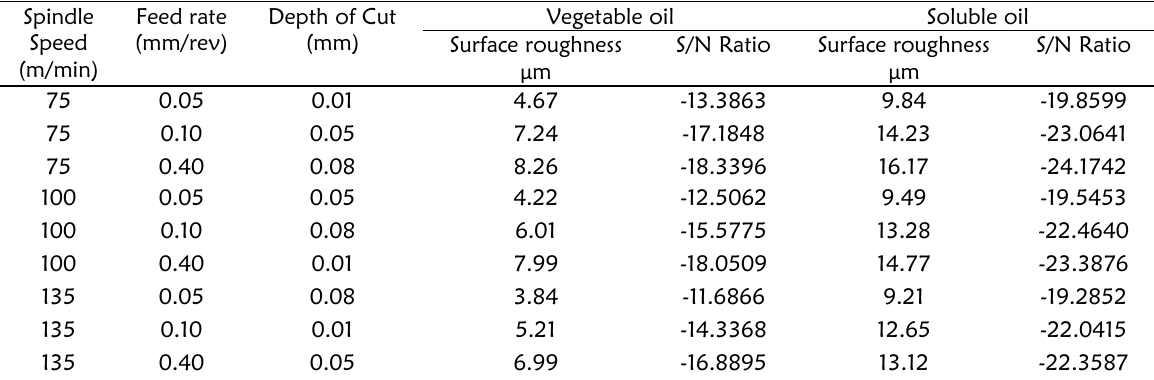
Table 4: Experiment layout, results and S/N ratios of surface roughness using vegetable oil and soluble oil